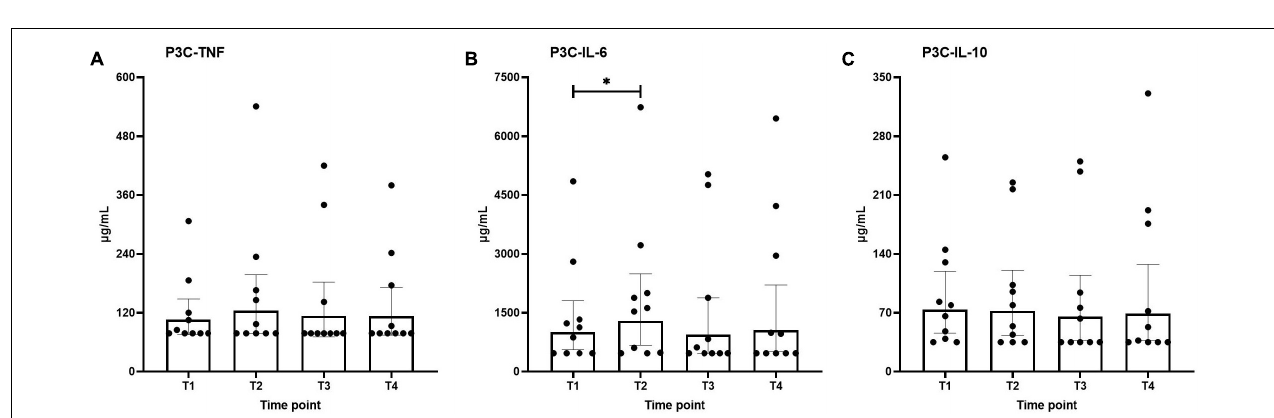
FIGURE 4 | Production of TNF (A) , IL-6 (B) , and IL-10 (C) following ex vivo stimulation of leukocytes with LPS. Data are represented as scatter plots with bars indicating geometric mean and whiskers representing 95% confidence interval (CI). Superscript font represents the number of missing values due to technical issues at each time point. ∗ p < 0.05 vs. T1.